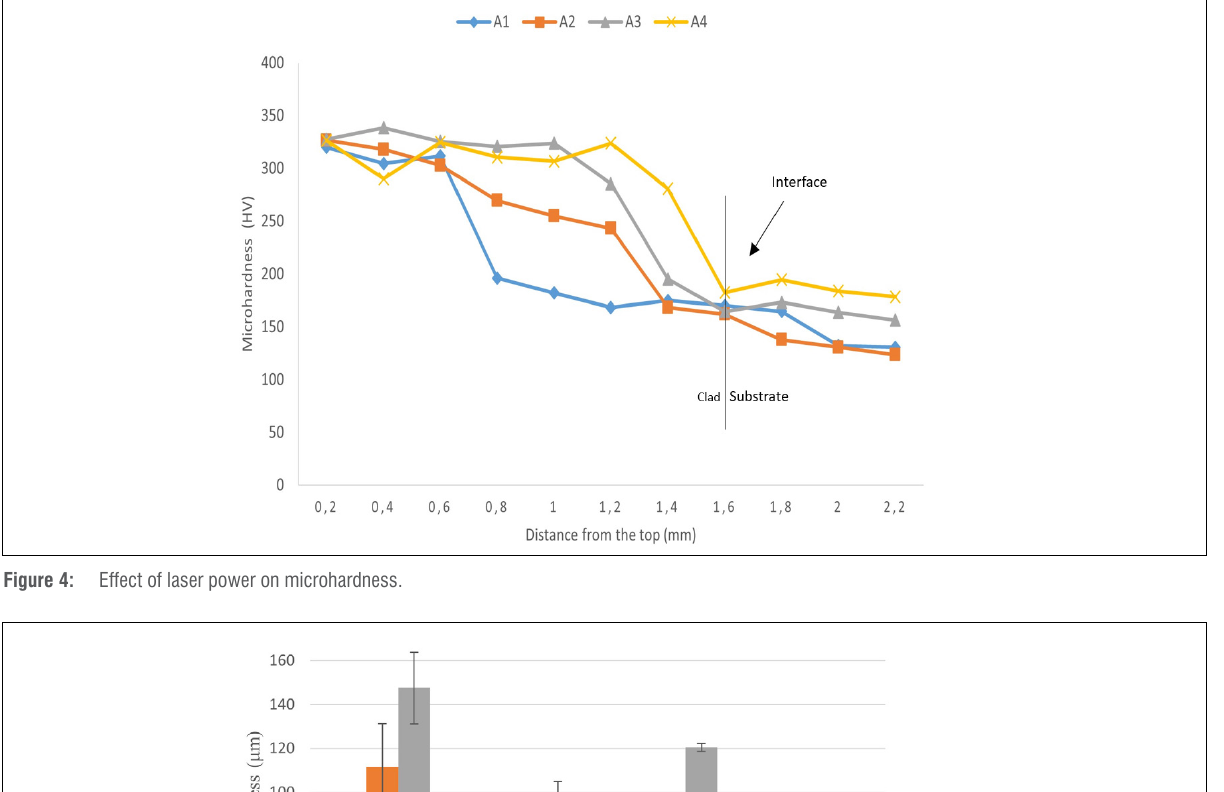
Figure 4: Effect of laser power on microhardness.